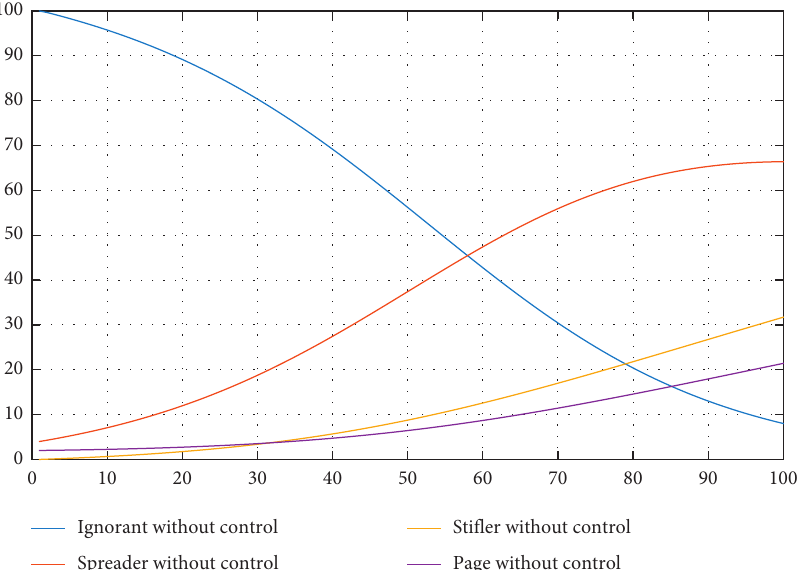
Figure 2: Dynamics without control